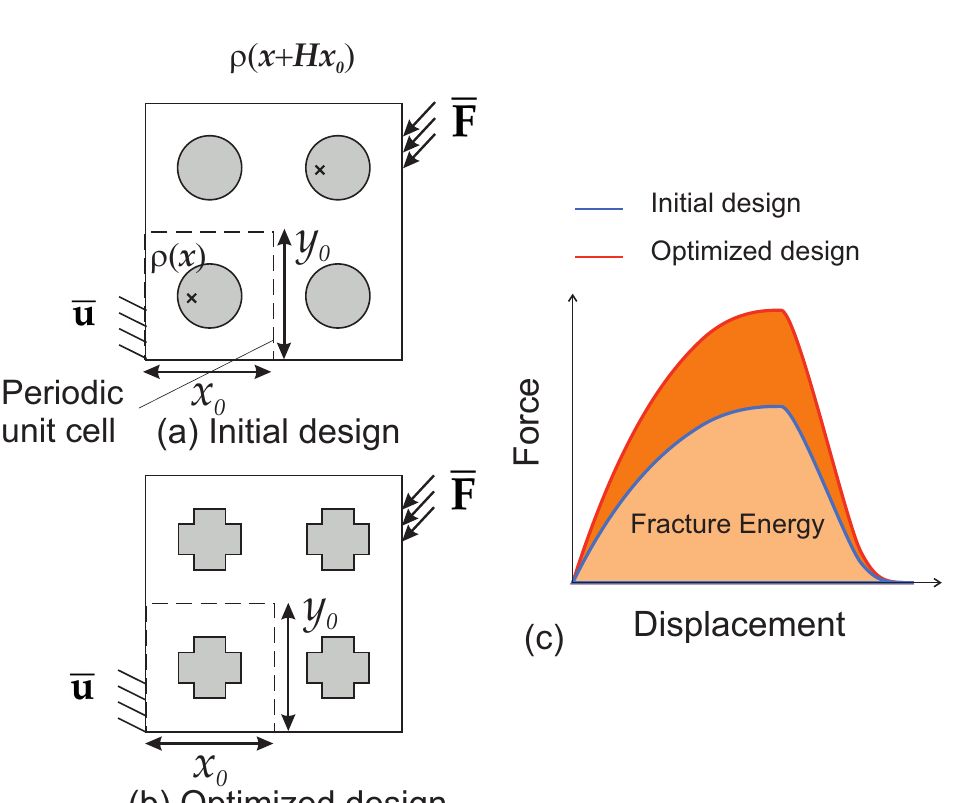
Figure 1. Schematic view of the methodology: the topology of the periodic unit cell is optimized such as the fracture energy of the whole structure is maximized through the whole fracturing process, from crack initiation until complete failure of the structure: ( a ) initial design; ( b ) optimized design; ( c ) load–displacement response of the structure for initial and optimized